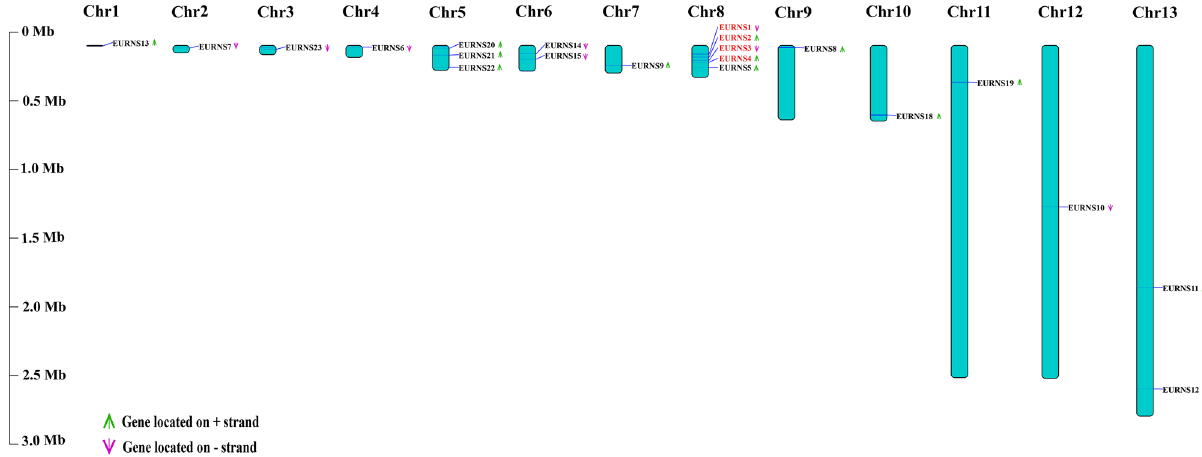
Figure 2. The chromosome distribution of EURNS genes. Only chromosomes contained EURNS genes are represented in figure. The chromosome number is indicated at the top and the length label in the left. The tandem duplication genes are in red color. The arrows next to genes shows the direction of the